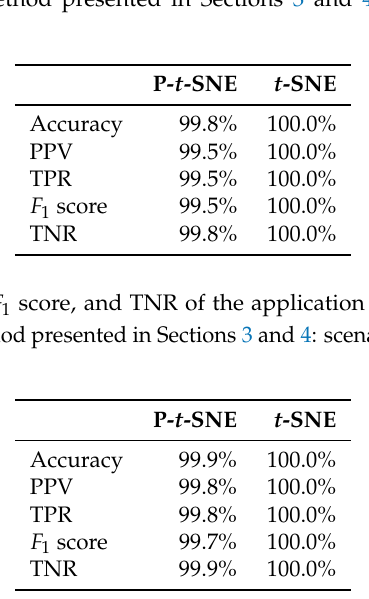
Table 6. Confusion matrix of the application of P- t -SNE and t -SNE damage detection and classification method presented in Sections 3 and 4: scenario 2 and the sum of the inverse distances approach. Predicted P- t -SNE t -SNE D 0 D 1 D 2 D 3 D 0 D 1 D 2 D 3 True D 0 100 100 1 0 0 0 100 0 0 D 2 0 100